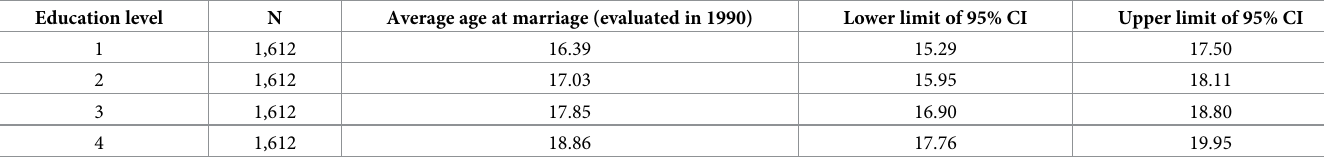
Table 2. Estimates of the average ages at marriage in 1990 for different education